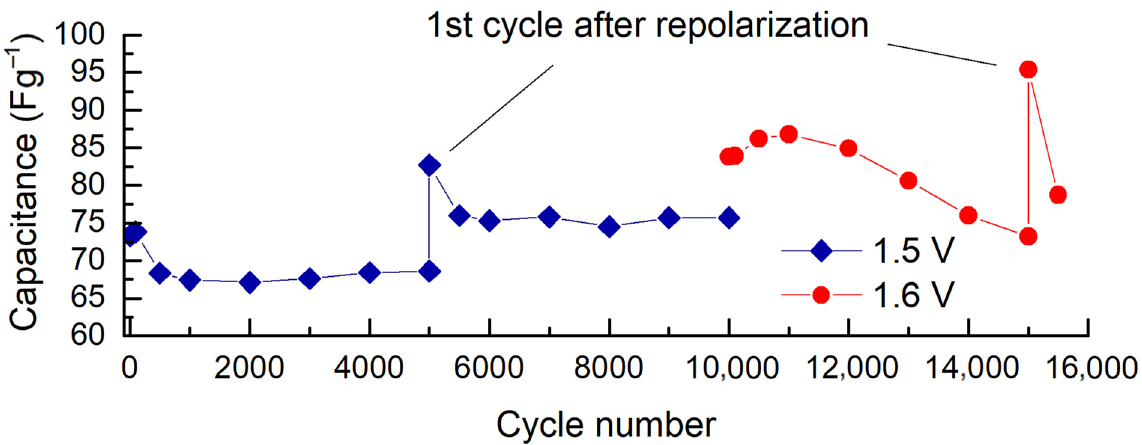
Figure 8. Cycle-life test profile with an unsymmetrical 2-electrode cell at a voltage scan rate of 20 mV s − 1 including the repolarization and operating voltage change.